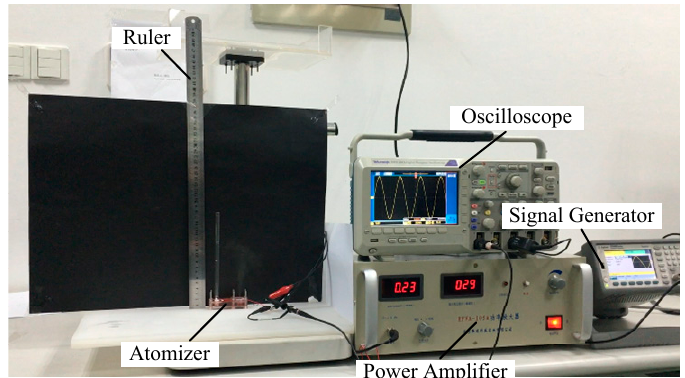
Figure 7. The measurement of the atomization rate and the atomization height.